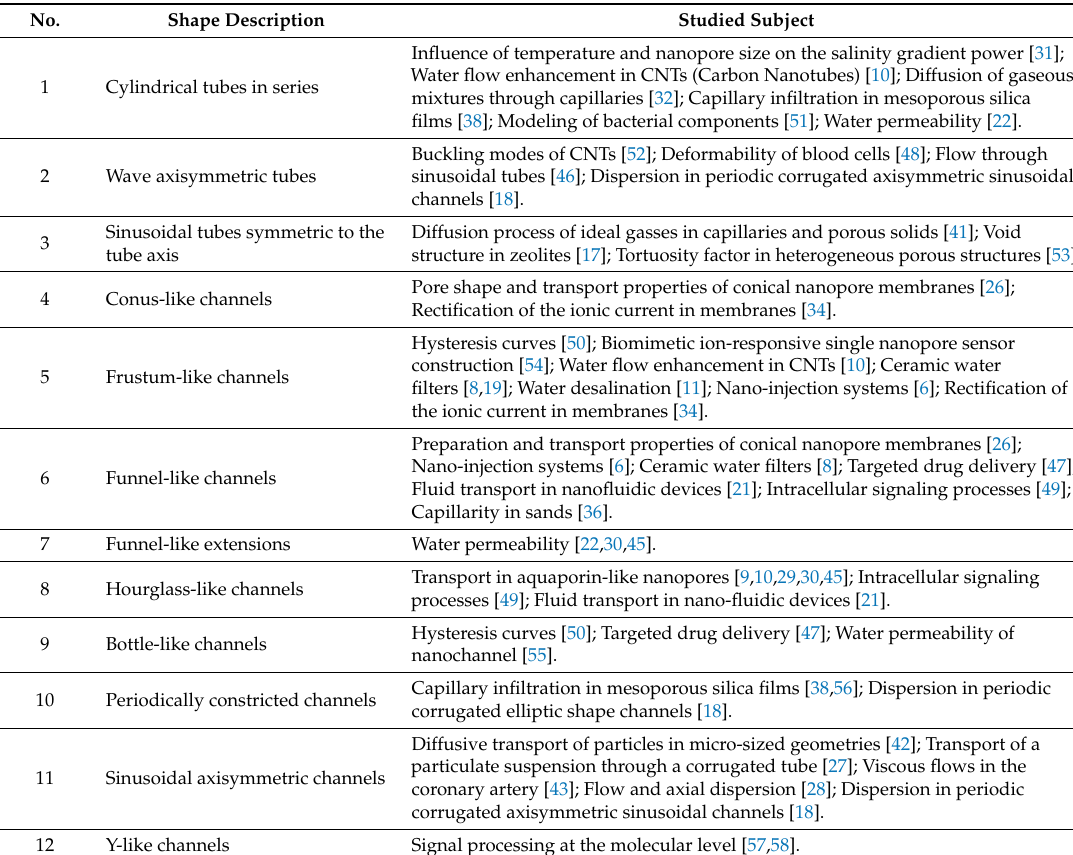
Table 1. Channels of irregular shapes with a round cross section in studies of properties of